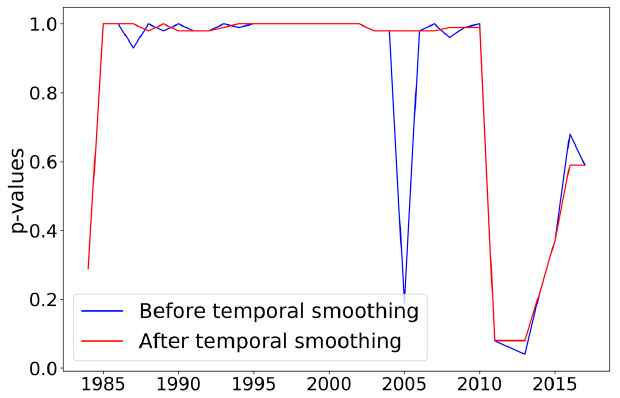
Figure 4. An example of temporal smoothing on the confidence index sequence of one